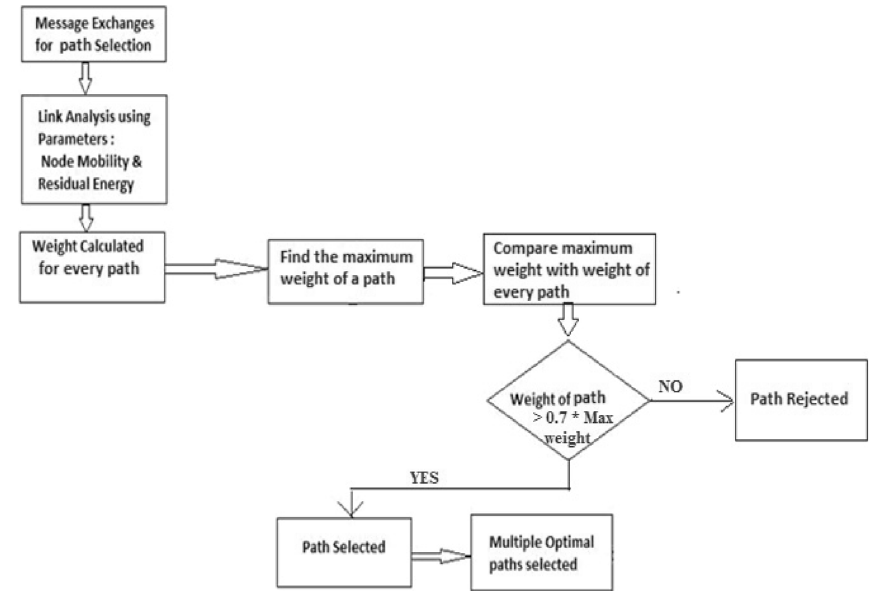
Fig. 5 Flow of the proposed weighted multipath